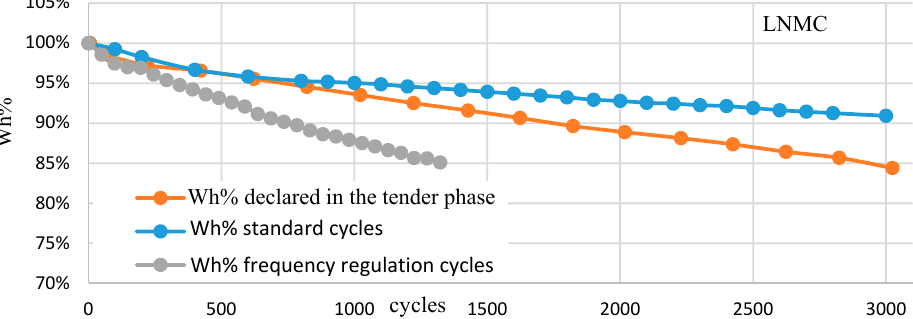
Figure 10. LNMC technology: comparison between the expected ageing, declared in the tender phase, and the ageing after the standard and frequency regulation cycles.